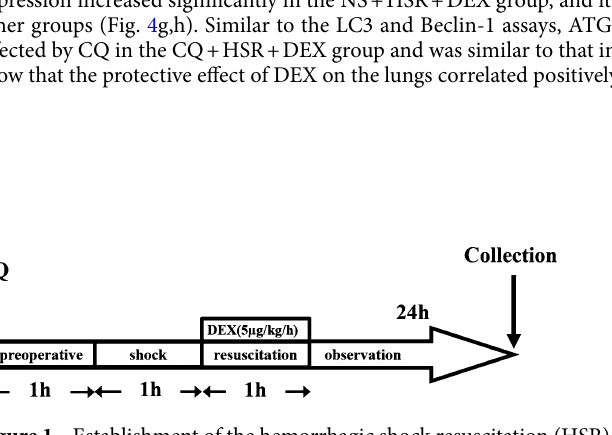
Figure 1. Establishment of the hemorrhagic shock resuscitation (HSR) rat model and chloroquine (CQ) and dexmedetomidine (DEX) administration schedule. The experimental animals were divided into six groups (n = 5–12 per group). Sham group: rats without hemorrhagic shock, normal saline (NS) was used instead of DEX and CQ; CQ + Sham group: Sham rats were pretreated with CQ 1 h in advance; NS + HSR + NS group: established rat HSR model using NS to replace DEX and CQ; NS + HSR + DEX group: HSR rats treated with DEX, and NS used instead of CQ; CQ + HSR + DEX group: CQ was intraperitoneally injected before the operation, and DEX was administered to HSR rats; CQ + HSR + NS group: HSR rats were pretreated with CQ 1 h in